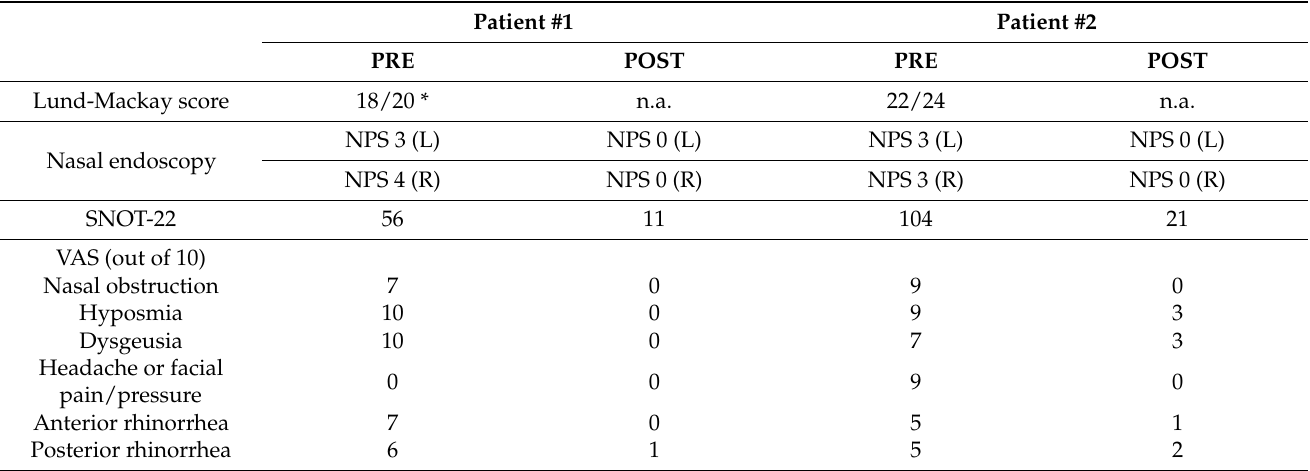
Table 1. Outcomes 2 months prior (PRE) and 12 months after reboot surgery (POST). Patient #1 Patient #2 PRE POST PRE